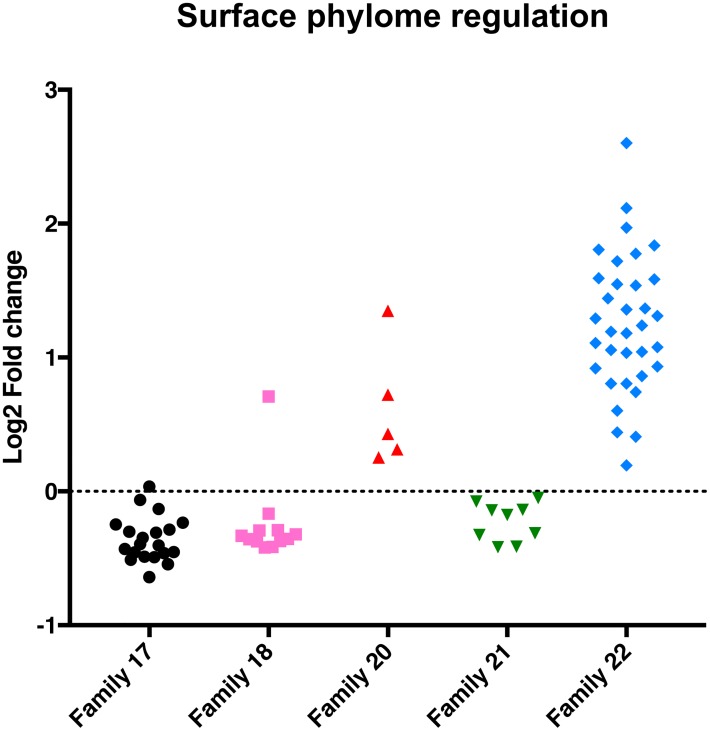
T. congolense-specific cell surface phylome regulation.Log2 fold change (FC) for T. congolense-specific cell surface phylome families. Members of Family 20 and Family 22 are upregulated at peak parasitaemia whereas other cell surface phylome families are not upregulated. Note that the fold change in expression levels of all family members are shown irrespective of their statistical significance.